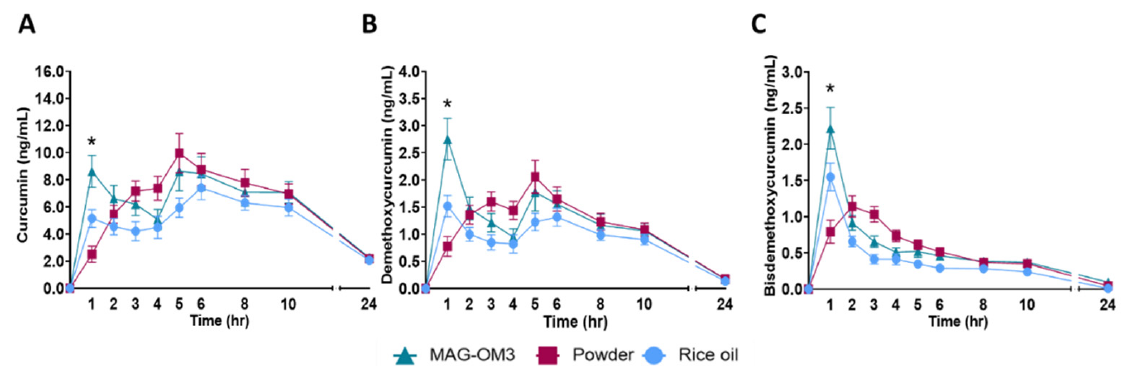
Figure 4. Pharmacokinetic over 24 h of total plasma ( A ) curcumin, ( B ) demethoxycurcumin and ( C ) bisdemethoxycurcumin (ng/mL) after providing a single dose intake of curcuminoids combined with monoglycerides omega-3 fatty acids (MAG-OM3), rice oil or alone in powder. The data are expressed means ± SEM and are delta over the baseline. A repeated measure two-way ANOVA was performed to compare the different formulations and a Turkey’s multiple comparisons test was performed when the ANOVA was significant to determined which group different from the other. * Represent p < 0.05.